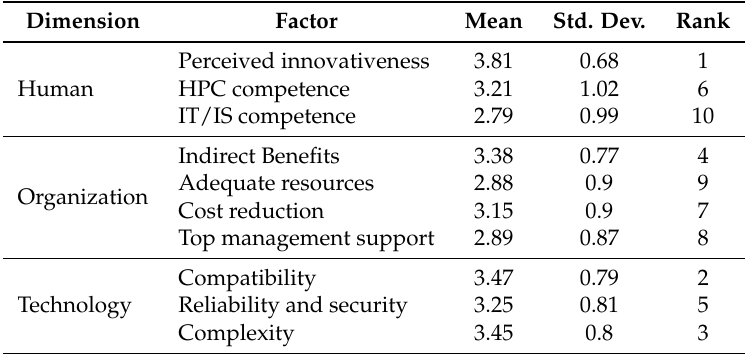
Table 3. Descriptive